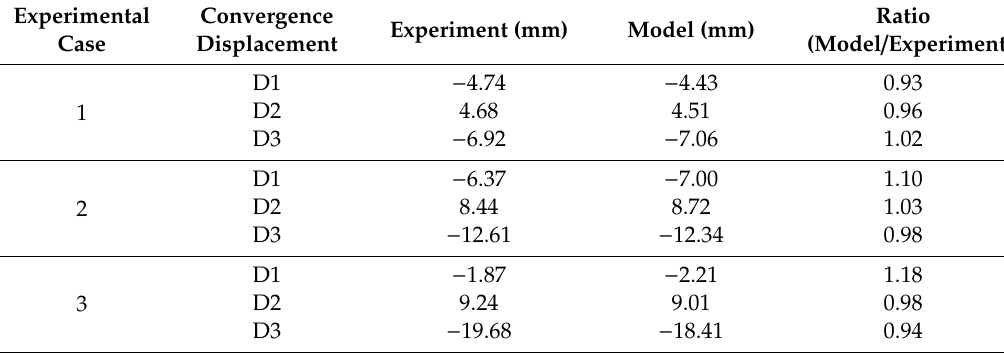
Table 4. Comparison of convergence